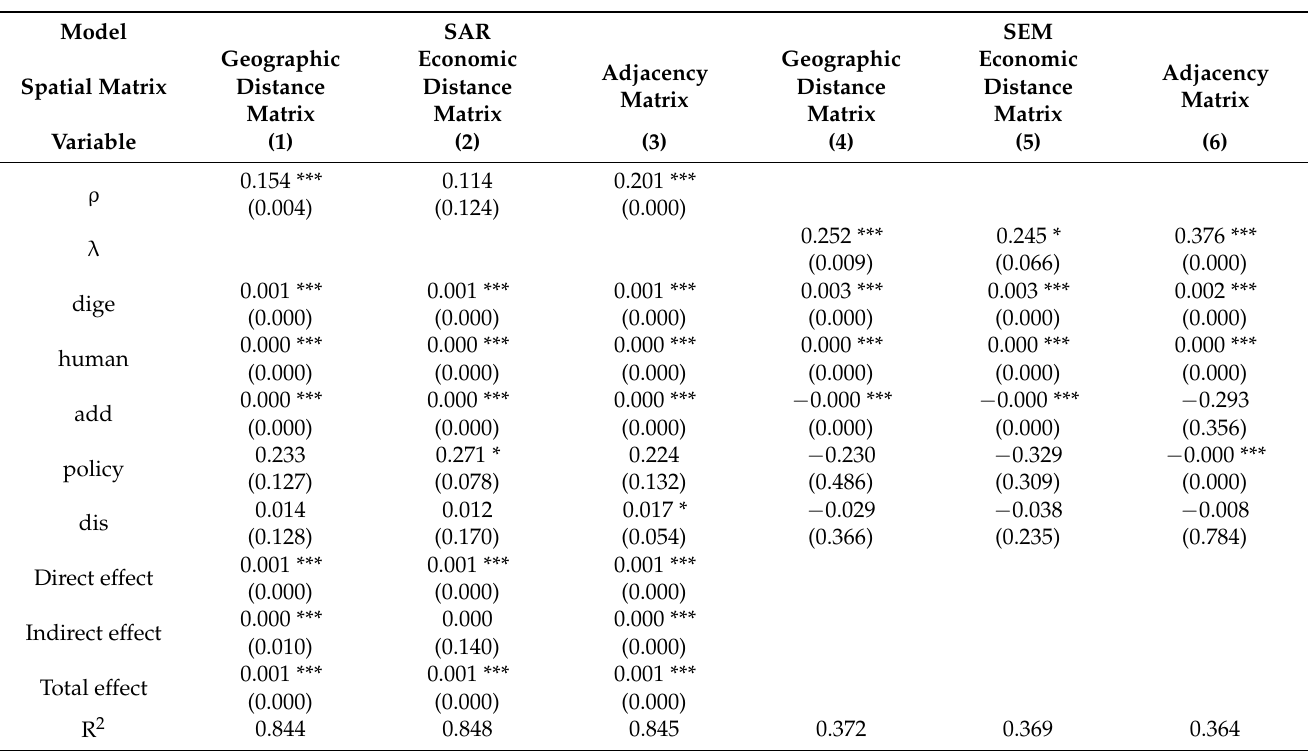
Table 8. Spatial model regression